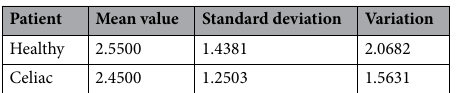
Table 11. Interpretation of variation in the number of large regions.